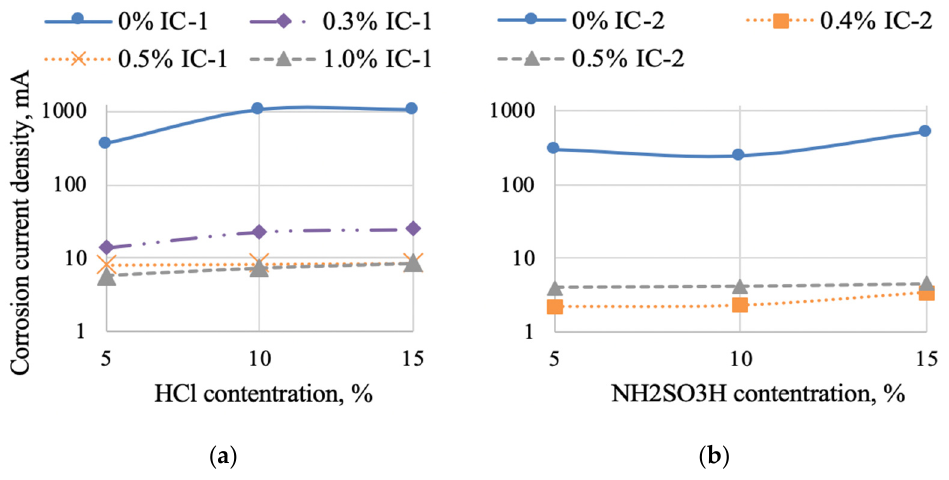
Figure 4. Change in corrosion current density within 24 h at 5, 10, and 15% wt. hydrochloric ( a ) and sulfamic acid ( b ) with the addition of various concentrations of inhibitors IC-1 ( a ) and IC-2 ( b ).